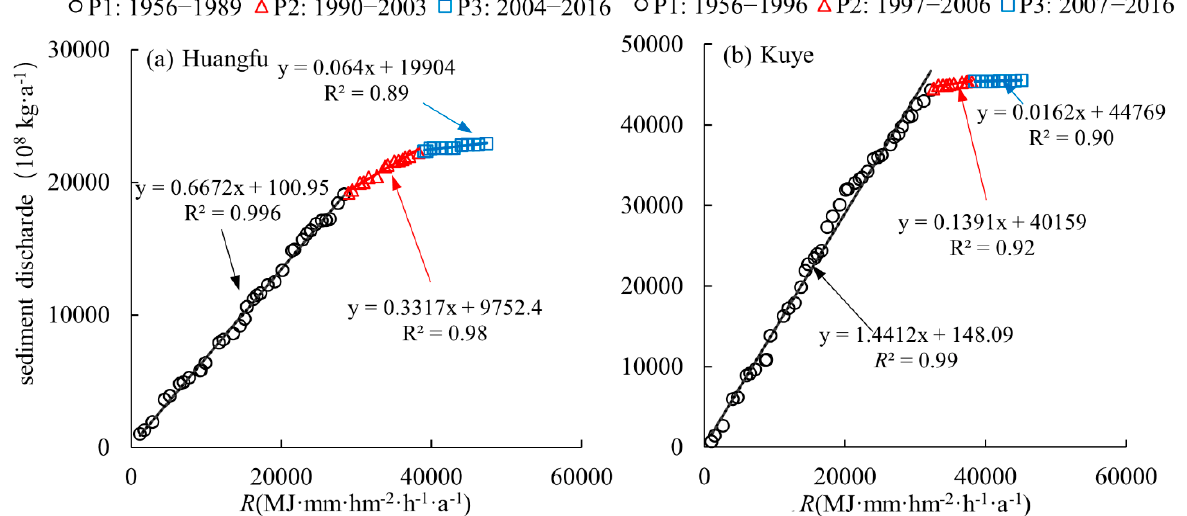
Figure 6 . Relationships between cumulative rainfall erosivity and sediment discharge in baseline and change periods in the Huangfu basin ( a ) and the Kuye basin ( b ).